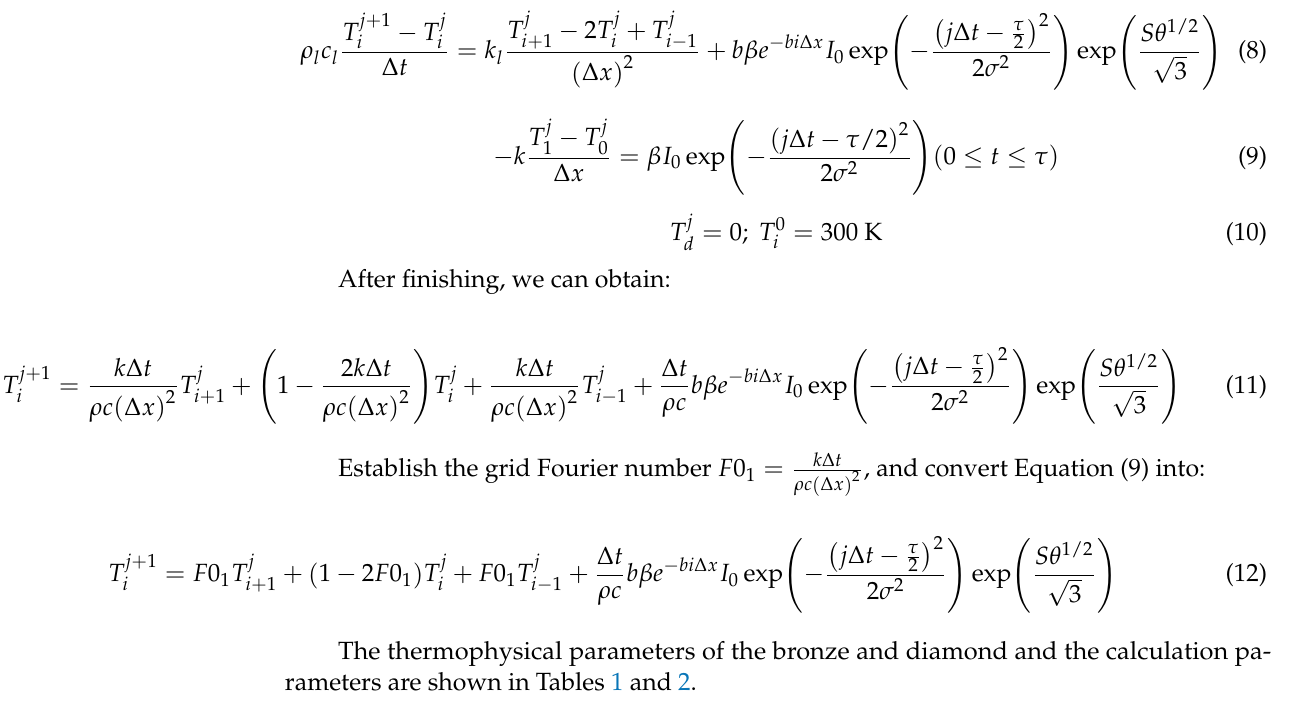
Table 1. Thermophysical parameters of the bronze and diamond.